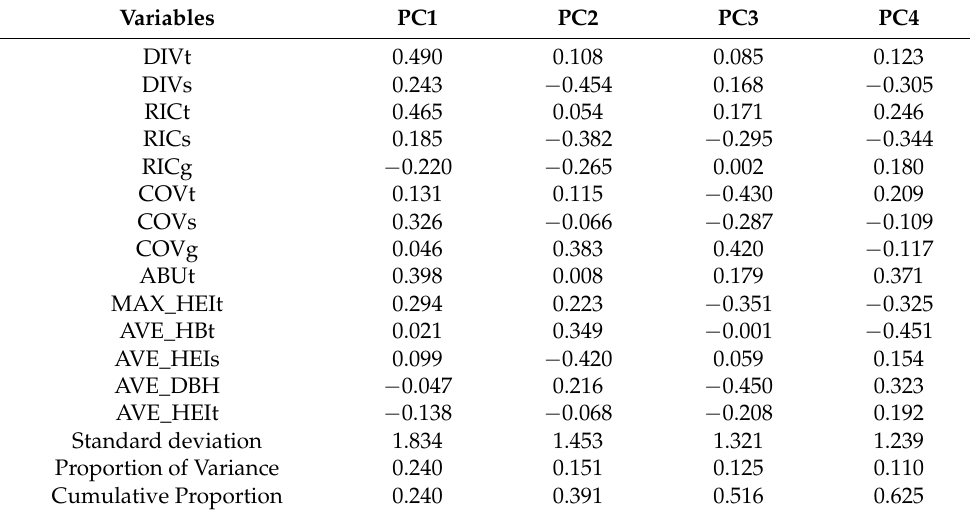
Table 1. Principal component analysis was performed on the variables (predictor variables) of dif- ferent vegetation habitats in urban mountain parks.